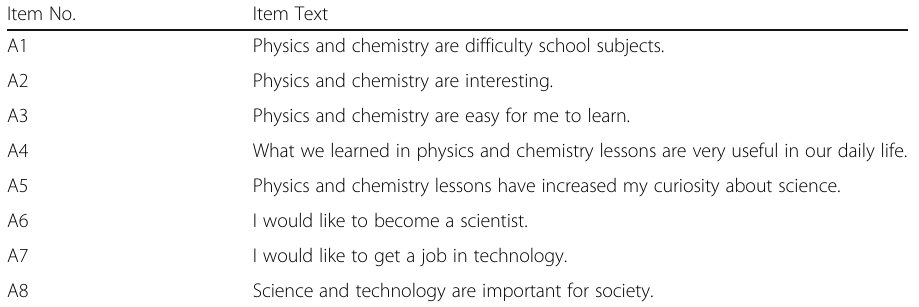
Table 1 Item texts for 8 questions on students ’ attitude Item